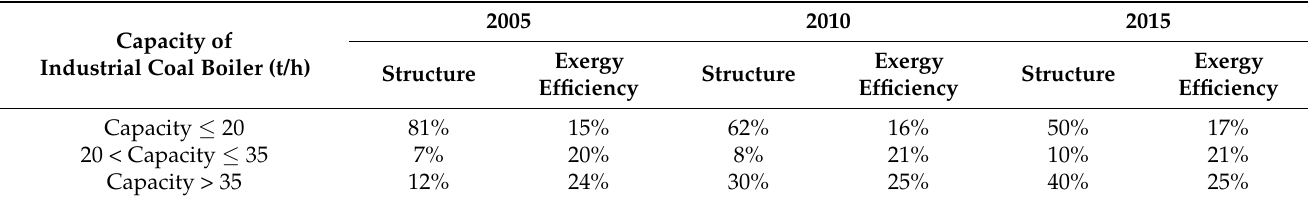
Table A7. Data for the “Dual Structure” of industrial coal boilers.